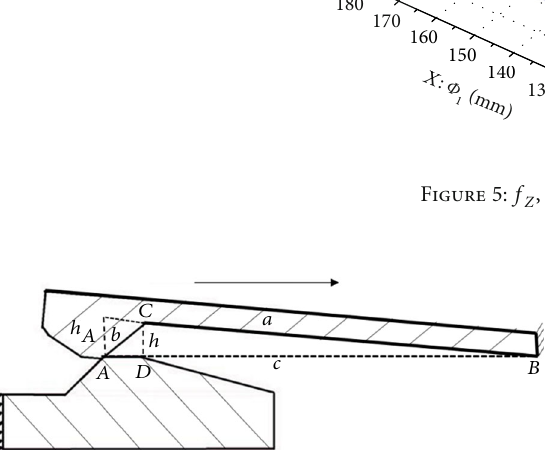
Figure 6: Force analysis of the fi nger lock in unlocking